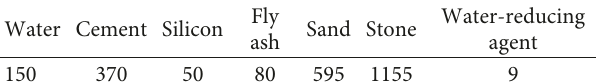
Table 2: Mixture ratios of the concrete (kg/m 3 ).